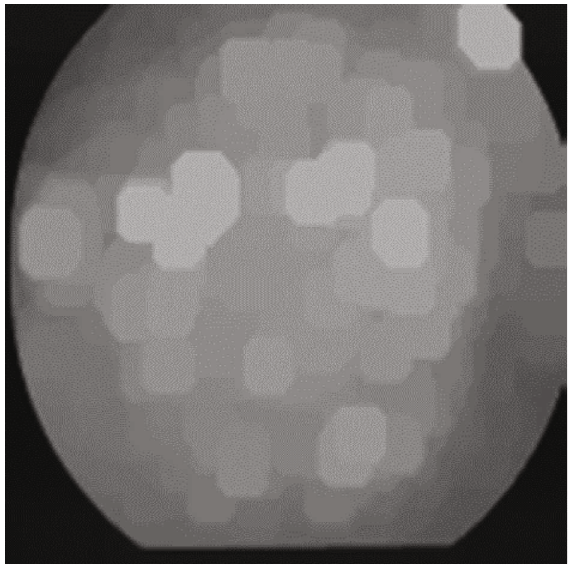
Figure 4: Erosion image.